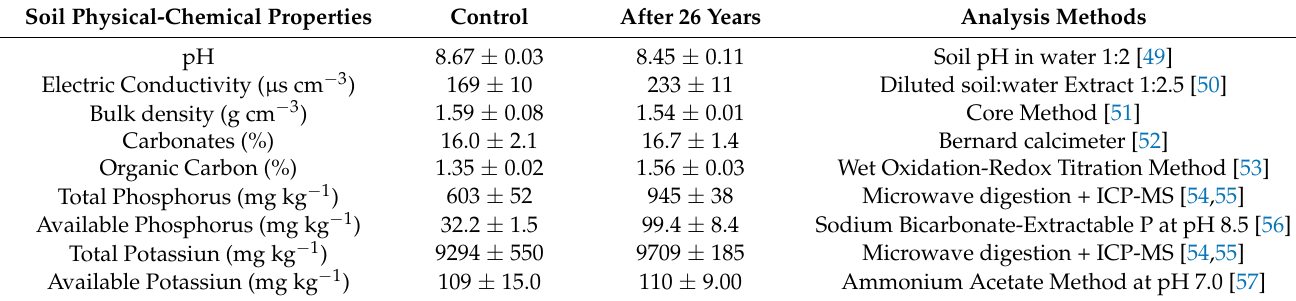
Table 1. Average values of the physicochemical properties of the tilled horizon (0–30 cm) of the study soil and analytical methods used. Control soil and soil amended with sewage sludge for 26 years. Values are given as the mean ± standard deviation ( n = 4).